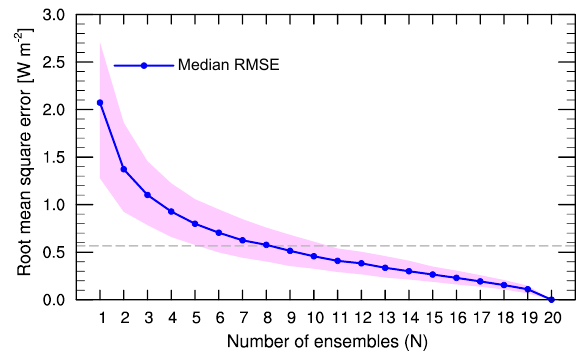
Figure 15. Root mean square error (RMSE) of the ensemble mean of the regional mean fire aerosol SCRE during 1–10 April over southern Mexico in simulations with different total numbers of en- semble members ( N ). The blue line represents the median RMSE of the 1000 groups (each group has N members/simulations). The grey line represents the threshold RMSE. Shaded area denotes the range between the 10th and 90th